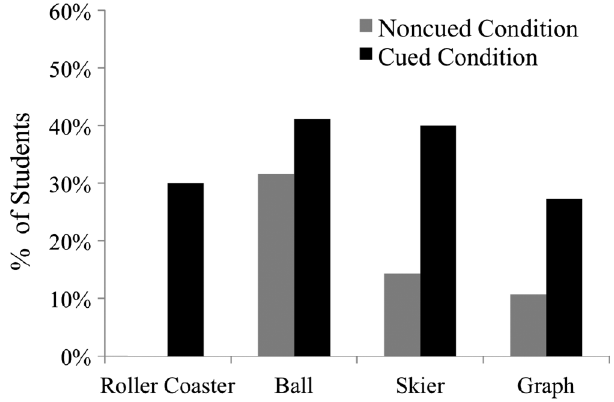
FIG. 6. Comparison of percentage of participants in cued and noncued conditions who gave the correct answer and reasoning on a similar problem. For example, 30% ¼ 6 = 20 students in the cued condition answering correctly on a similar roller coaster